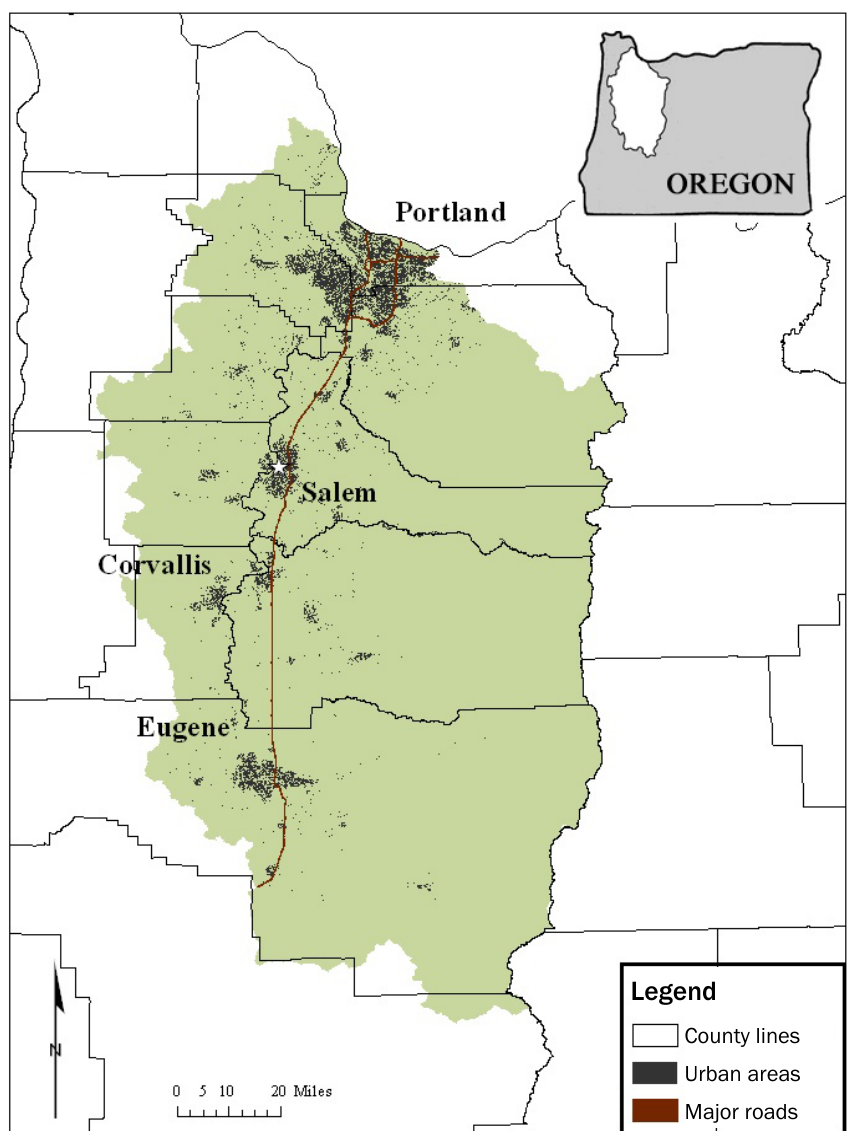
Figure 2. The Willamette Valley Growing